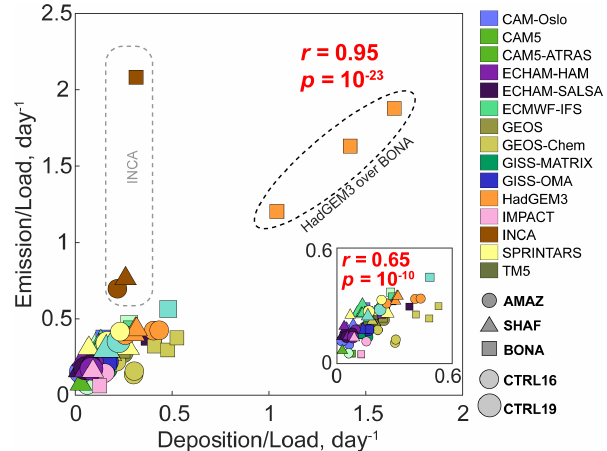
Figure 10. Dependence of the modeled aerosol lifetime on the timescale of total deposition. The color, shape, and size of dots in- dicate different models, three fire regions, and two AeroCom con- trol experiments, respectively. The embedded diagram shows the same results zoomed in to a smaller scale (excluding INCA and HadGEM3 in BONA). The Pearson correlation ( r ) and p value ( p ) are